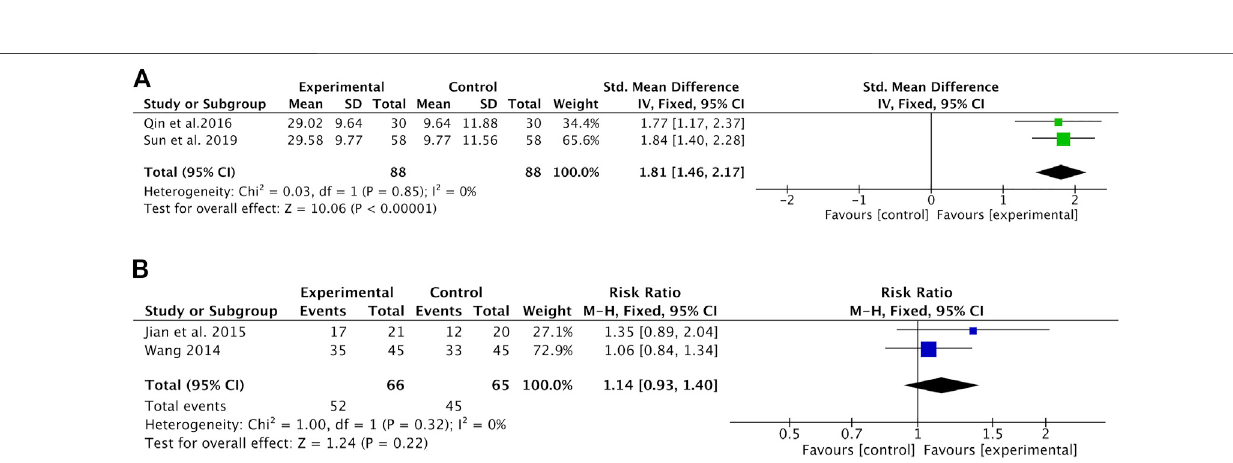
FIGURE 4 | Forest plot of KPS of Astragalus-containing CHM combined with CT versus CT alone; outcomes: (A) mean ± SD of KPS; (B) the number of patients with nondeterioration KPS. KPS, Karnofsky performance score; CHM, Chinese herbal medicine; CT, chemotherapy.